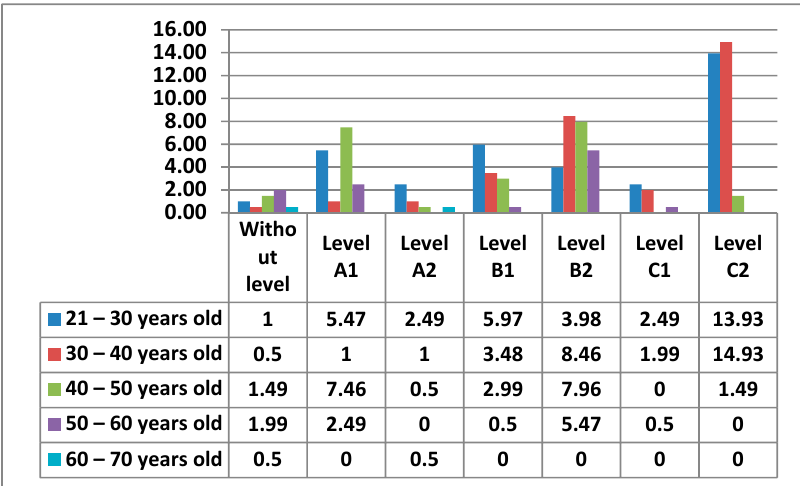
Figure 27. Digital competence in teachers by age in Area 5.